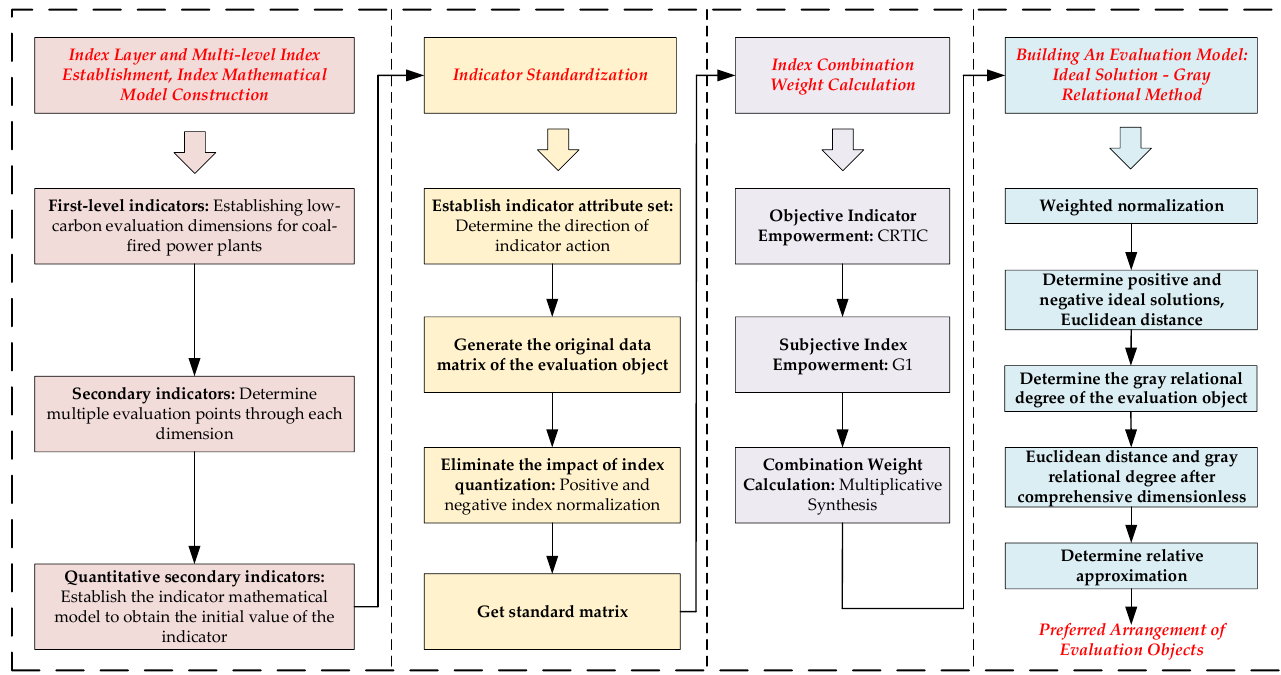
Figure 3. Block diagram of comprehensive evaluation process of low carbonization difference of coal power at the source end.